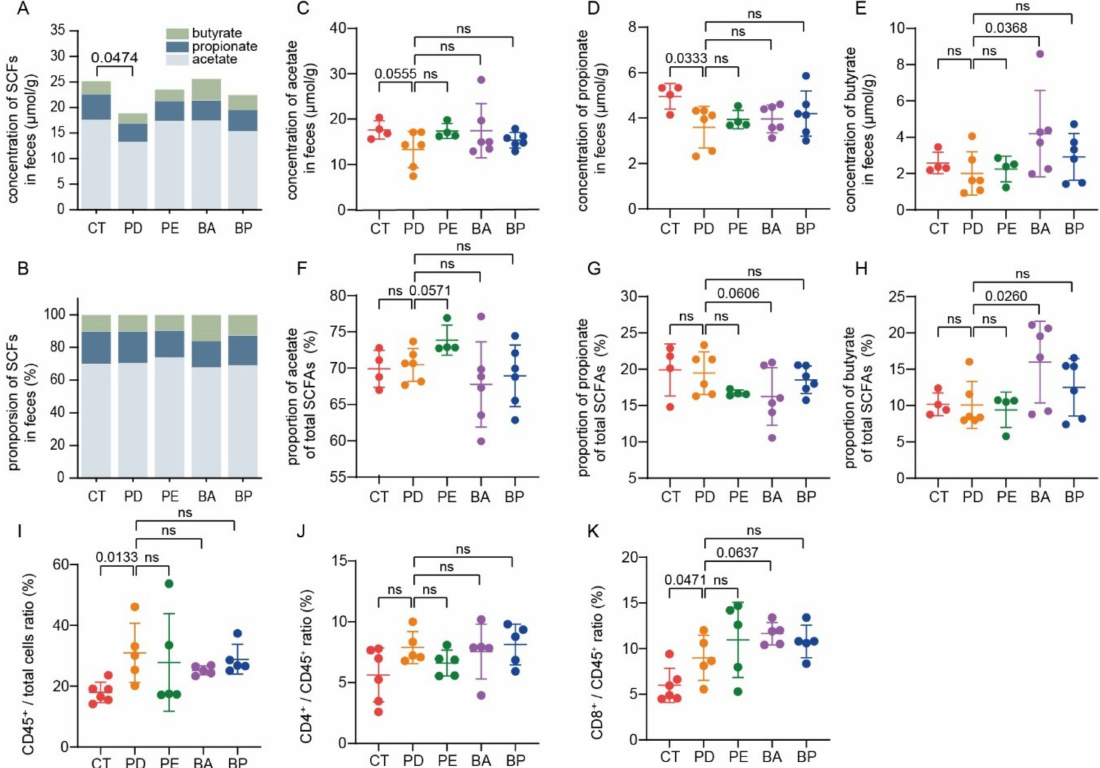
Figure 5. Bilberry anthocyanins promote the production of short-chain fatty acids (SCFAs) and tumor immune infiltration. The total content of SCFAs ( A ) and the proportions of individual to total SCFAs in feces. ( B ) Quantification of the content of acetate ( C ), propionate ( D ) and butyrate ( E ) in feces by gas chromatography. The proportions of acetate ( F ), propionate ( G ) and butyrate ( H ) to total SCFAs in feces. Quantification of total T lymphocytes ( I ), CD4 + ( J ) and CD8 + ( K ) T cells in tumor tissues by flow cytometry. Di ff erences were tested using Student’s t -test; ns, not